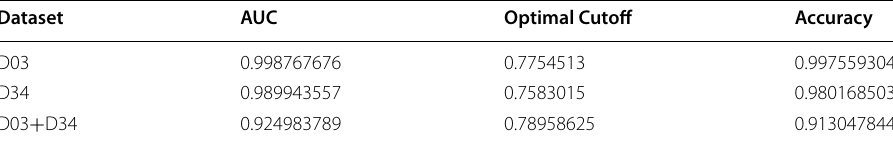
Table 2 XGBoost gives worse results when combining two datasets appropriately